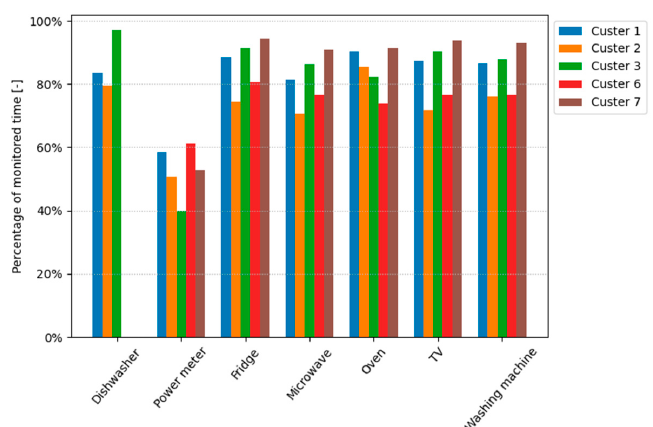
Figure 7. Percentage of monitored time concerning overall monitoring campaign.